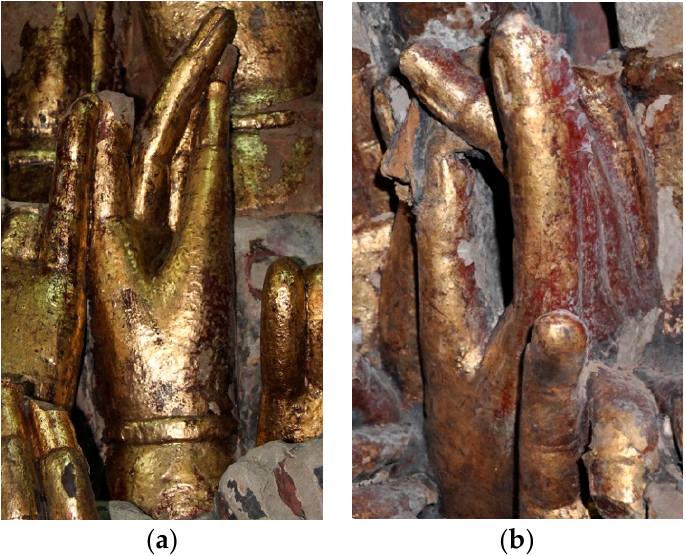
Figure 13. Photographs of missing fingers and their reference hands: ( a ) hand 9-7-s4; ( b ) hand 9-5-s6; which is the hand symmetric to 9-7-s4.